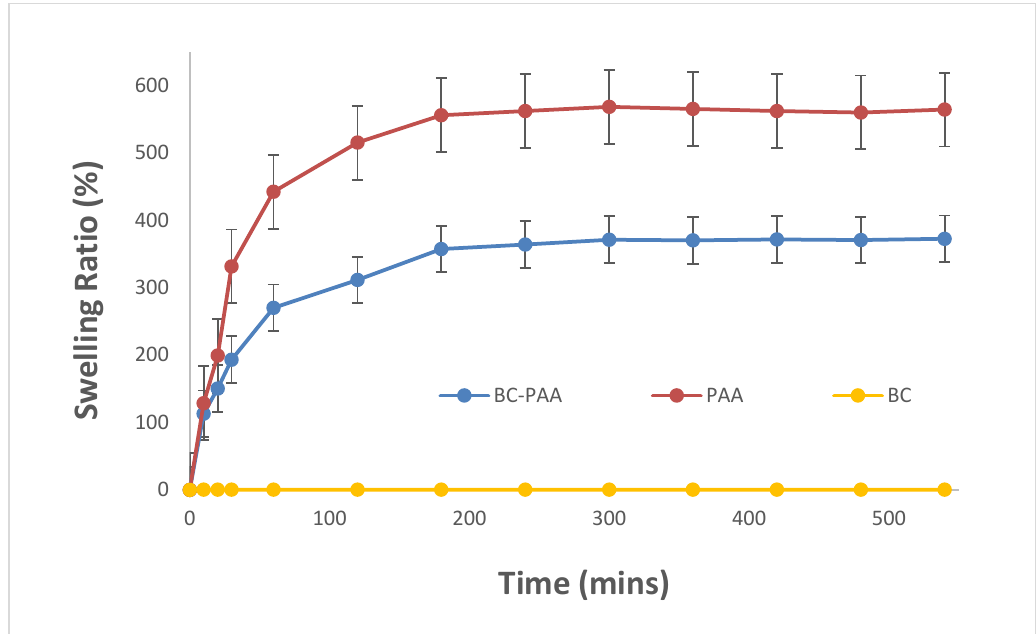
Figure 4. Swelling ratio of BC, PAA, and BC-PAA.